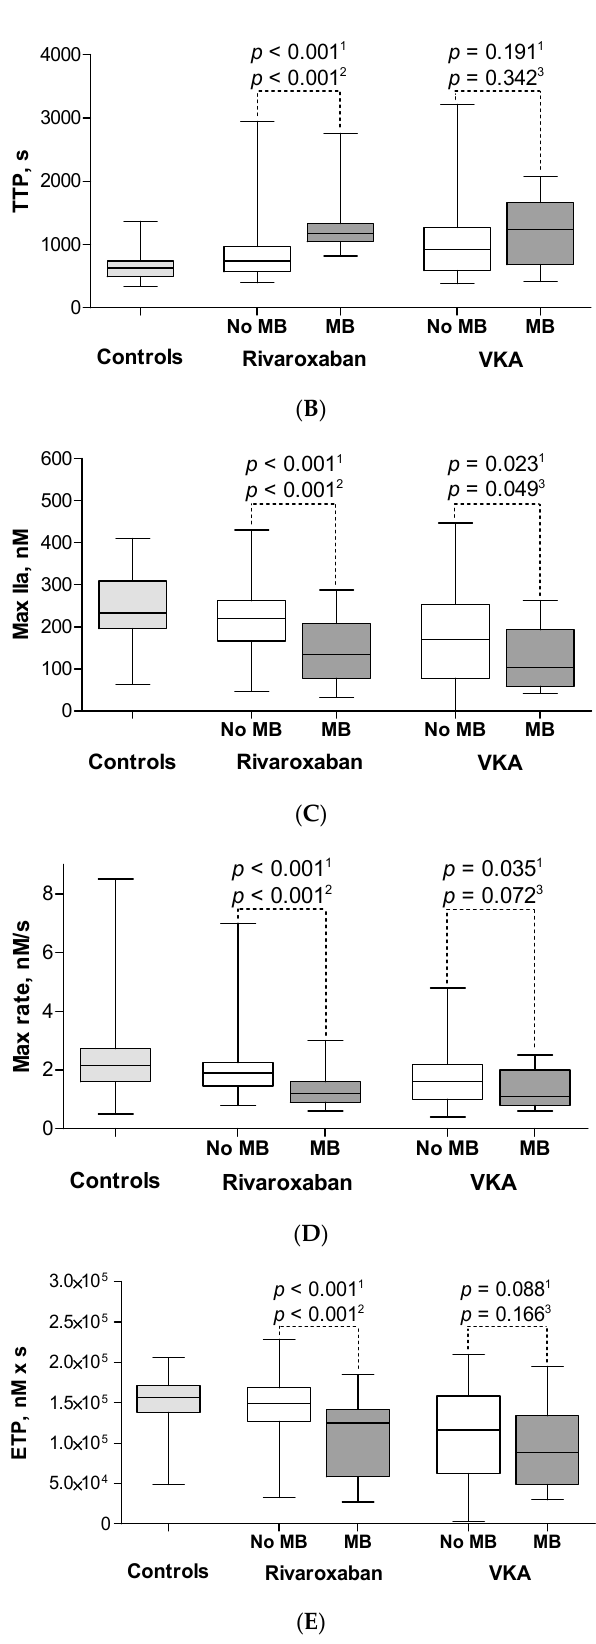
Figure 1. The calibrated automated thrombography parameters in the studied groups. Patients on rivaroxaban with MB had longer lag time ( A ), longer TTP ( B ), lower max IIa ( C ), lower max rate ( D